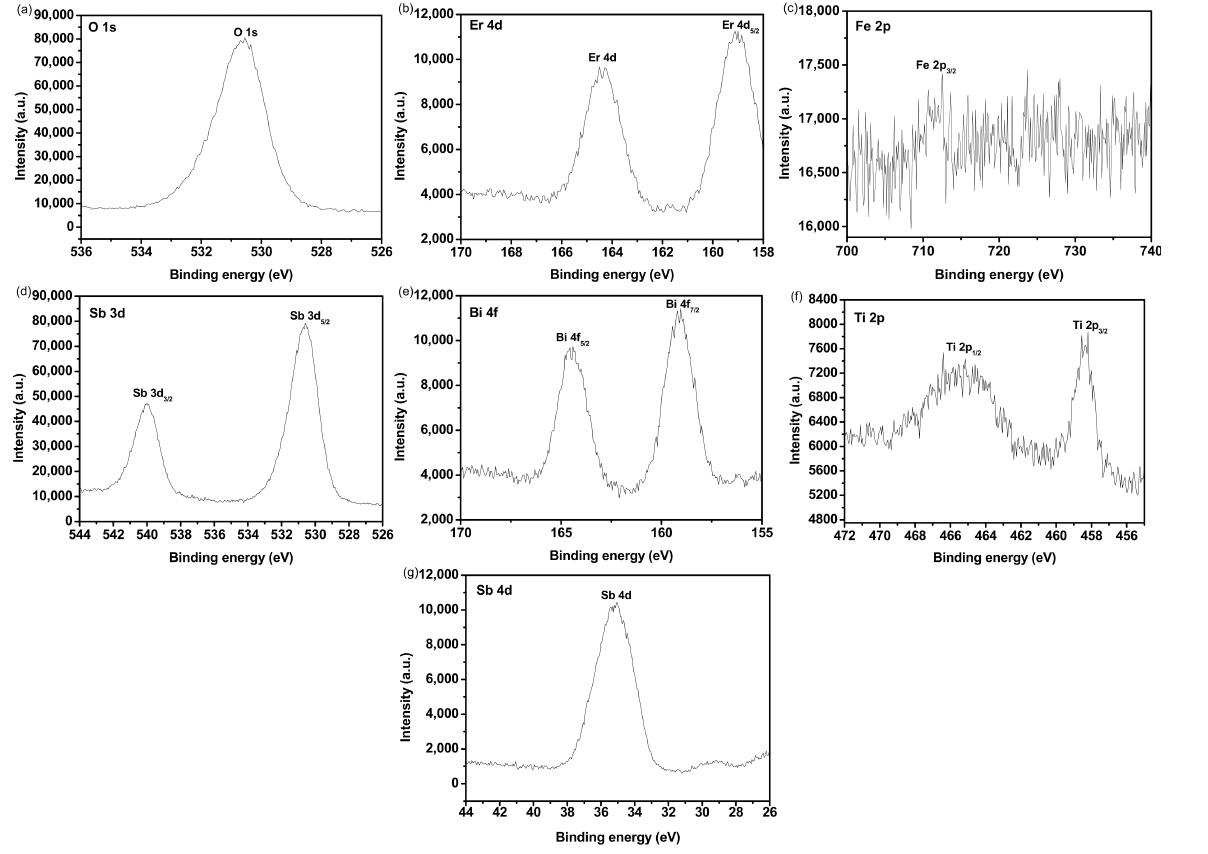
Figure 6. ( a ) XPS spectra of O 2 − which derives from the EBHP before the reaction; ( b ) XPS spectra of Er 3+ which derived from the EBHP before the reaction; ( c ) XPS spectra of Fe 3+ which derived from the EBHP before the reaction; ( d ) XPS spectra of Sb 5+ (Sb 3d) which derived from the EBHP before the reaction; ( e ) XPS spectra of Bi 3+ which derived from the EBHP before the reaction; ( f ) XPS spectra of Ti 4+ which derived from the EBHP before the reaction; ( g ) XPS spectra of Sb 5+ (Sb 4d) which derived from the EBHP before the reaction.